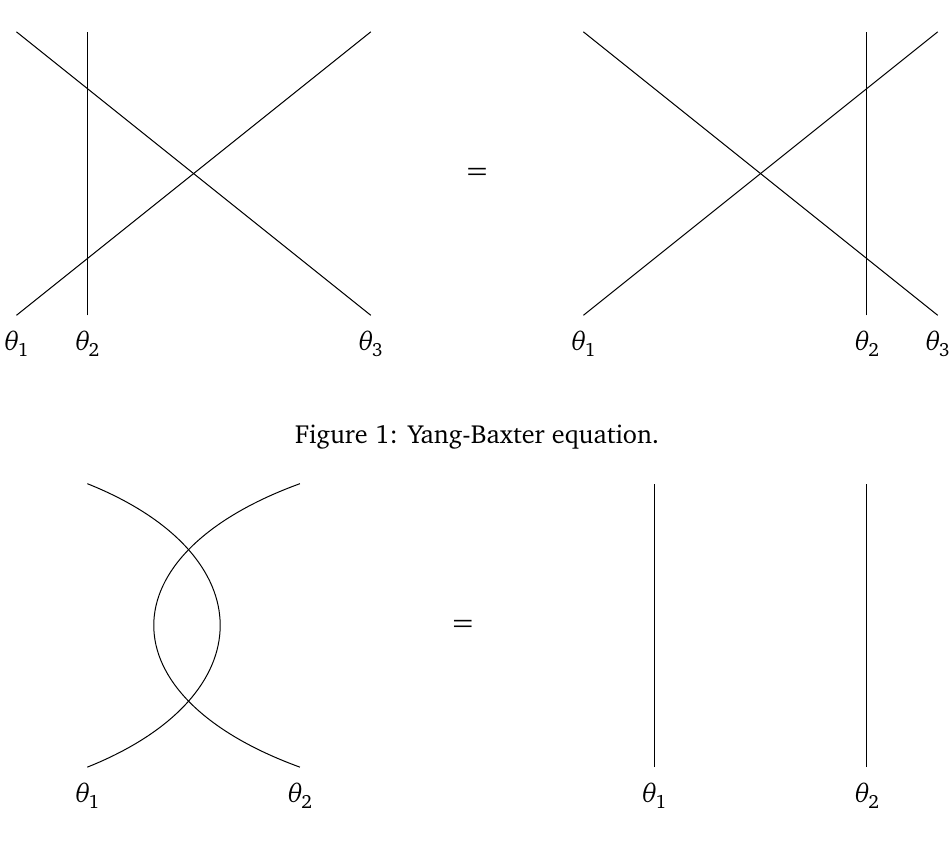
Figure 2: Unitarity